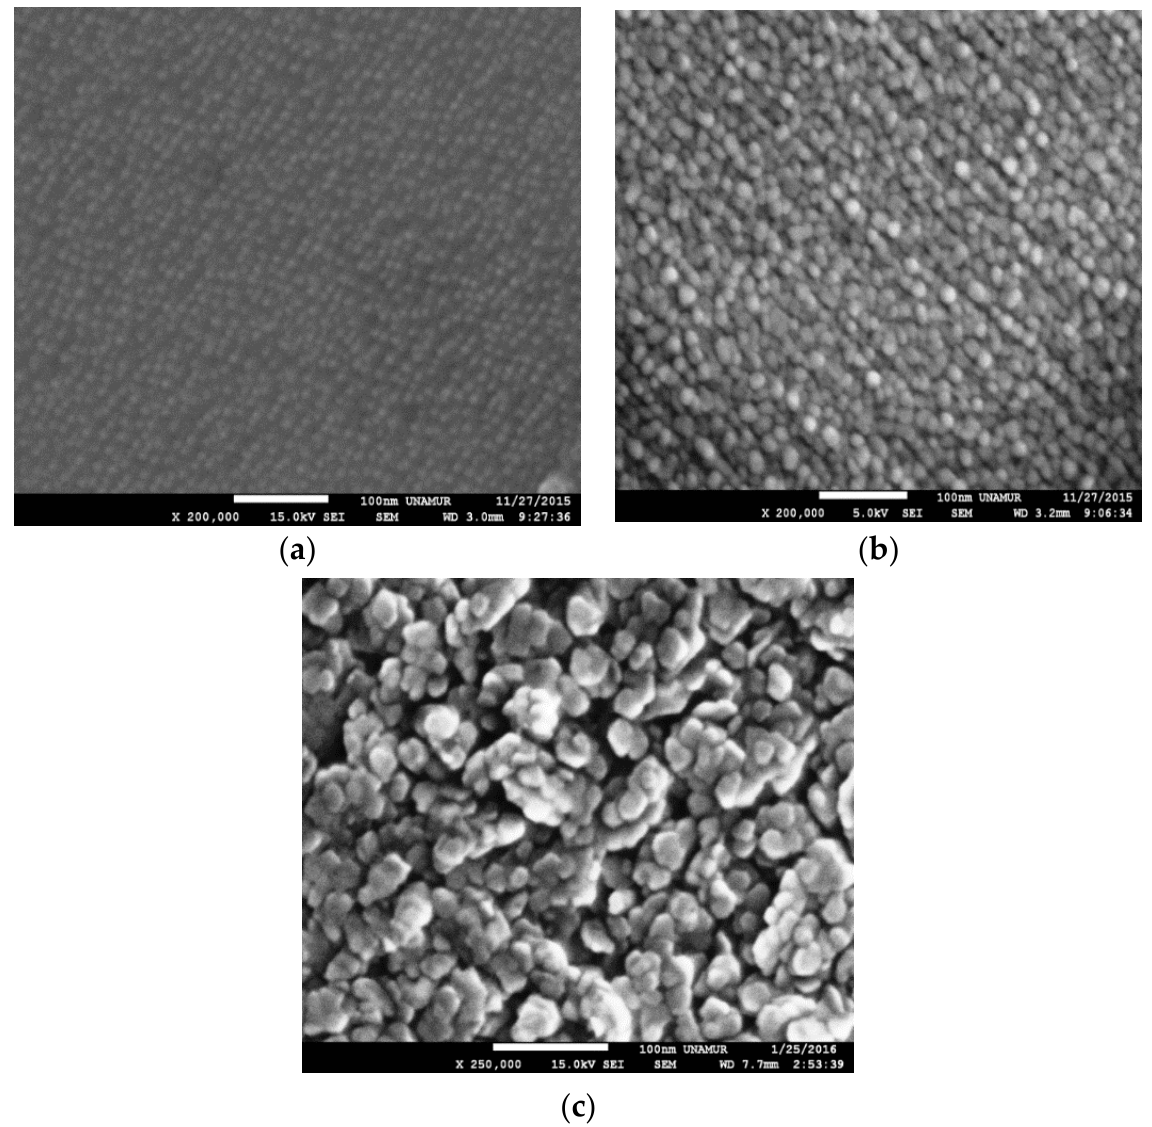
Figure 4. SEM images for samples (#a) and (#c) of ZnO films synthesized on silicon substrates: ( a ) heated at 200, ( b ) heated at 400 °C, ( c ) SEM image taken at magnification of 250 × 10 3 of sample heated at 400 °C.